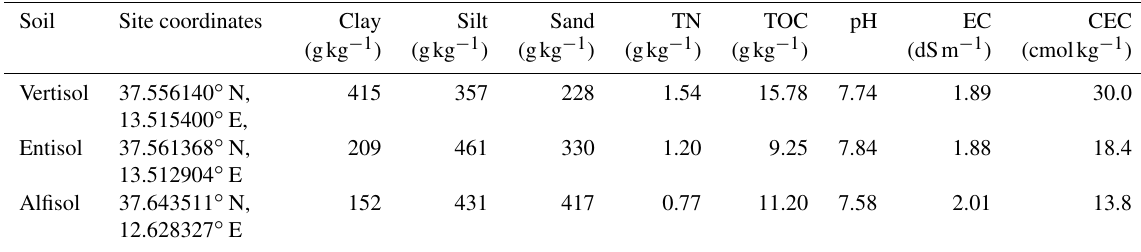
Table 1. Physical and chemical properties of the three different soils used in the experiment. Soil Site coordinates Clay Silt Sand TN TOC pH EC